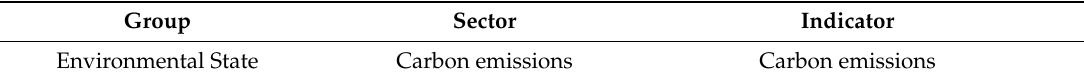
Table 1. Initial carbon emission governance indicators for